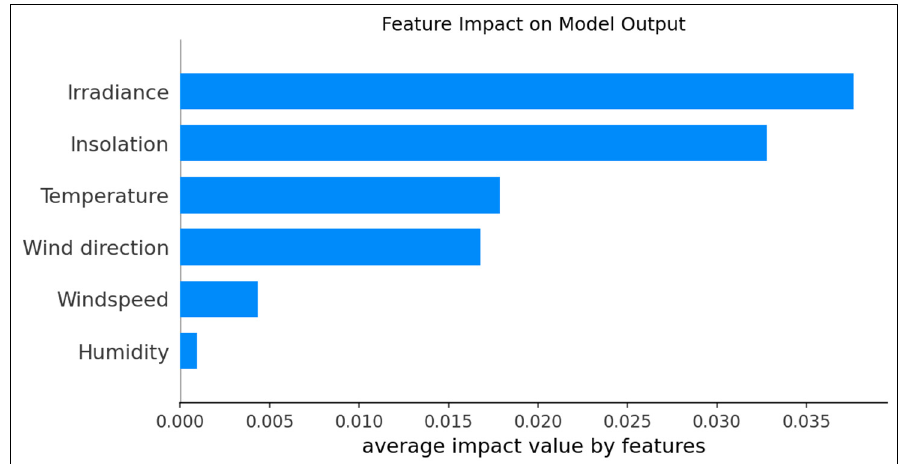
Figure 8. Impact of feature on overall performance of the Transformers model.